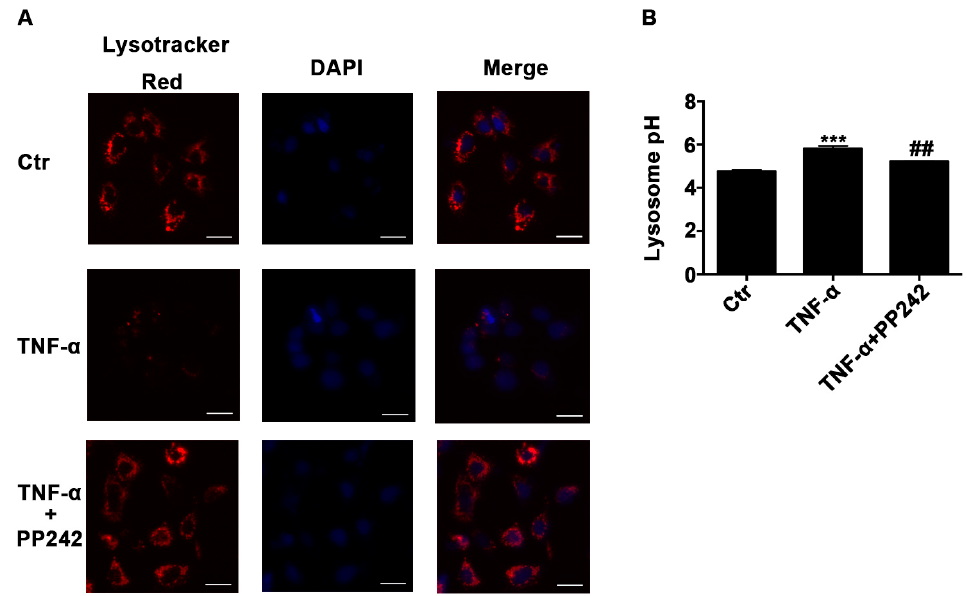
Figure 3. Lysosomal acidic environment was impaired after TNF- α treatment and PP242 rescued it. ( A ) Images of Caco-2 cells labeled with Lysotracker Red DND-99 dye after TNF- α (10 ng/mL, 48 h) and/or PP242 (1 μ m, 24 h) treatment. The red and blue fluorescence were represented the lysosome and nucleus, respectively. Scale bar: 30 μ m. ( B ) Lysosomal pH changes of Caco-2 cells labeled with Lysosensor Yellow/Blue DND-160 after TNF- α and/or PP242 treatment. Data were shown as mean ± SD and replicated three times. *** p < 0.001 versus control group. ## p < 0.01 versus TNF- α group. Ctr, control group.